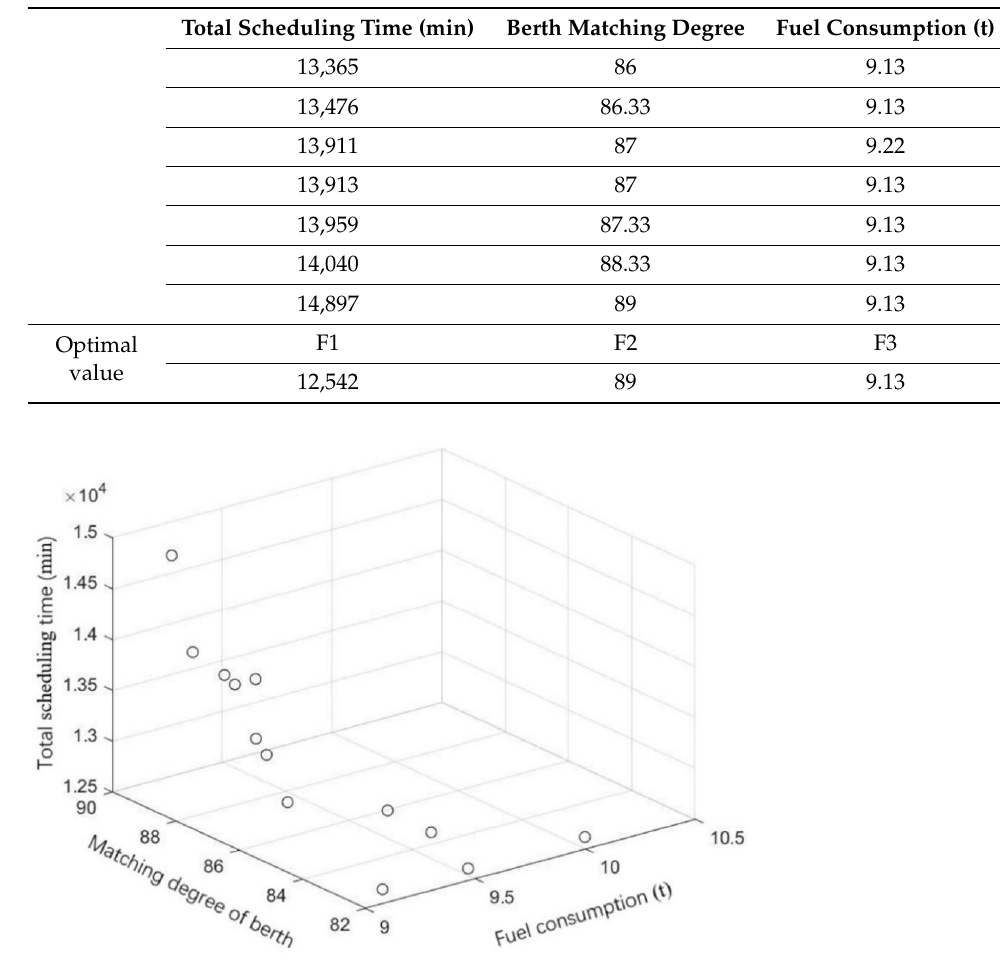
Figure 6. Pareto frontier diagram.